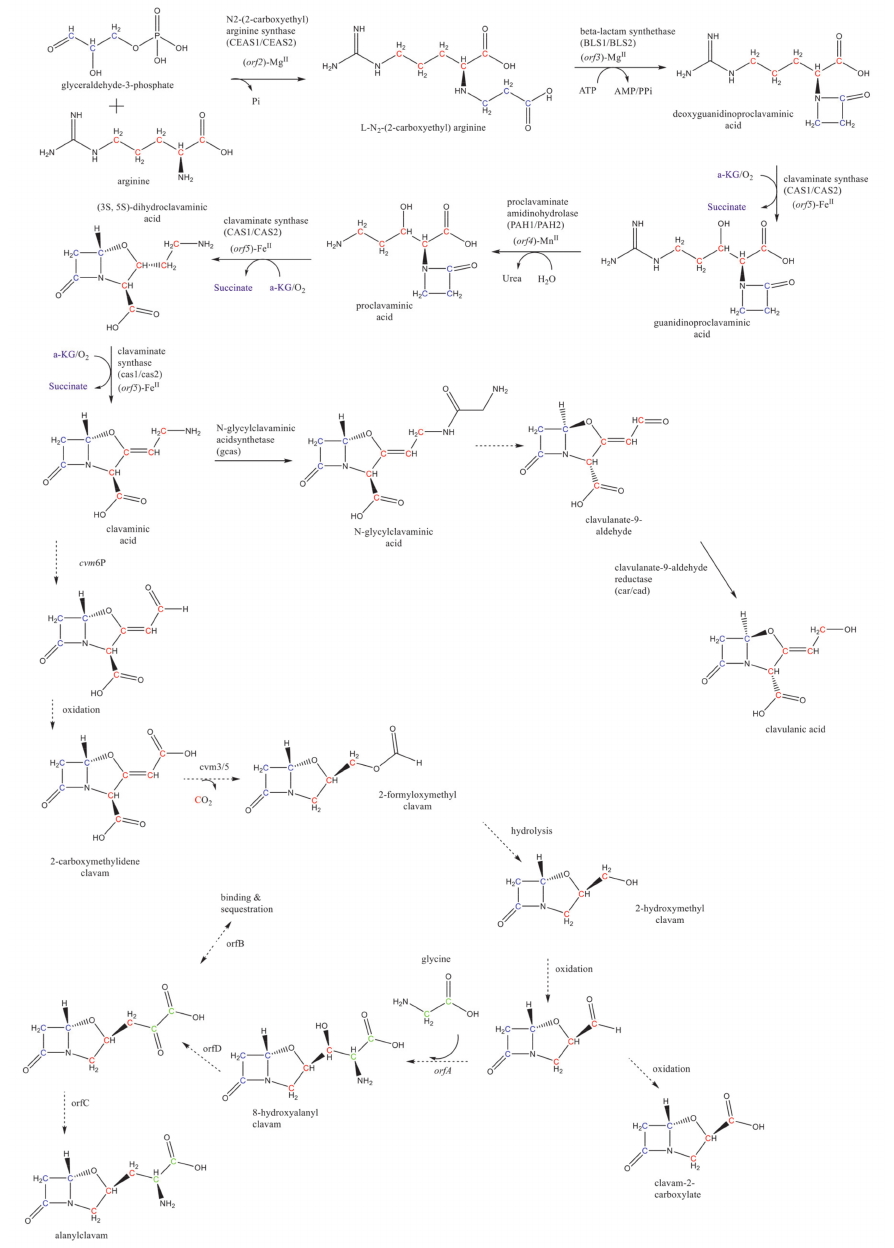
Figure 3. Summary of the CA biosynthetic pathway in S. clavuligerus . The green, blue, and red Cs represent the carbon atoms coming from metabolic intermediates such as glycine, glyceraldehyde 3-phosphate, and L-arginine, respectively. Adapted from the work in